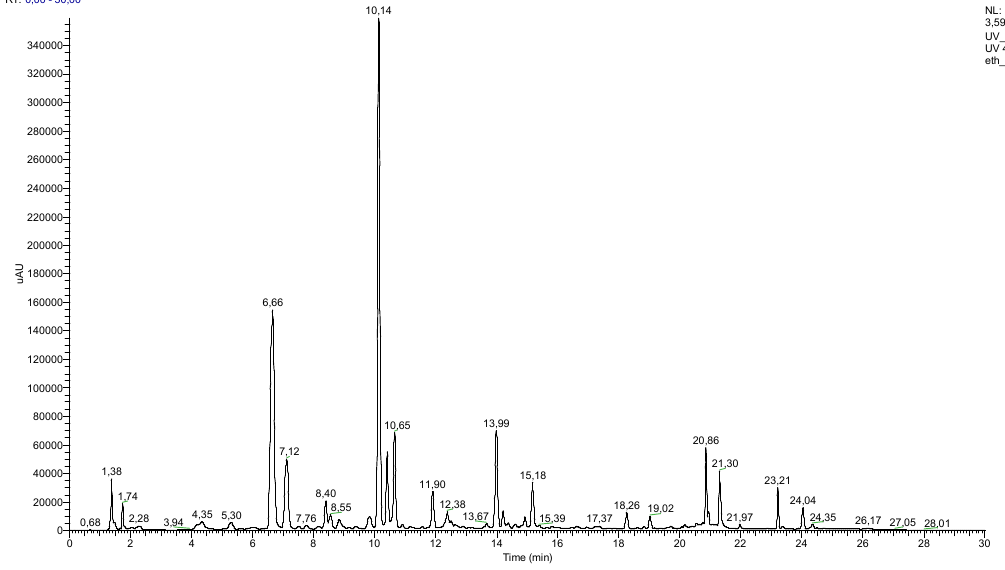
Figure 2. UHPLC chromatogram of S. stellata ethanolic extract recorded at 305 nm.